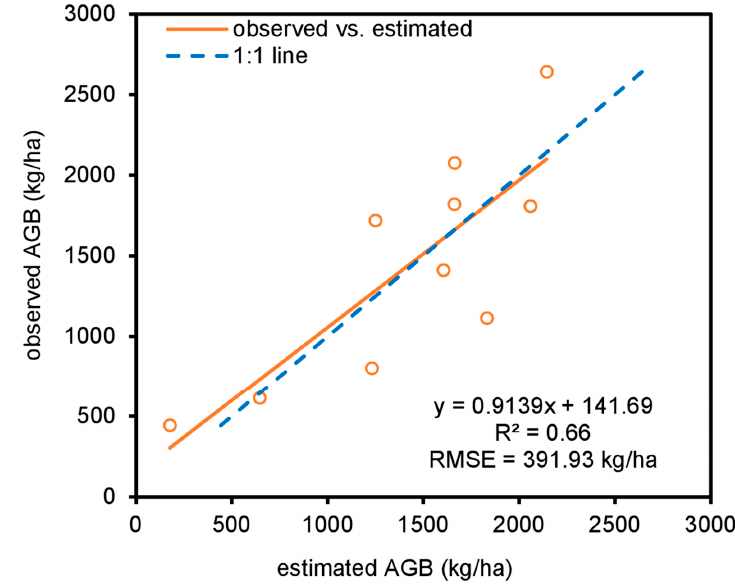
Figure 10. Relationship between observed and estimated aboveground biomass (AGB) from the generalised additive model. generalised additive